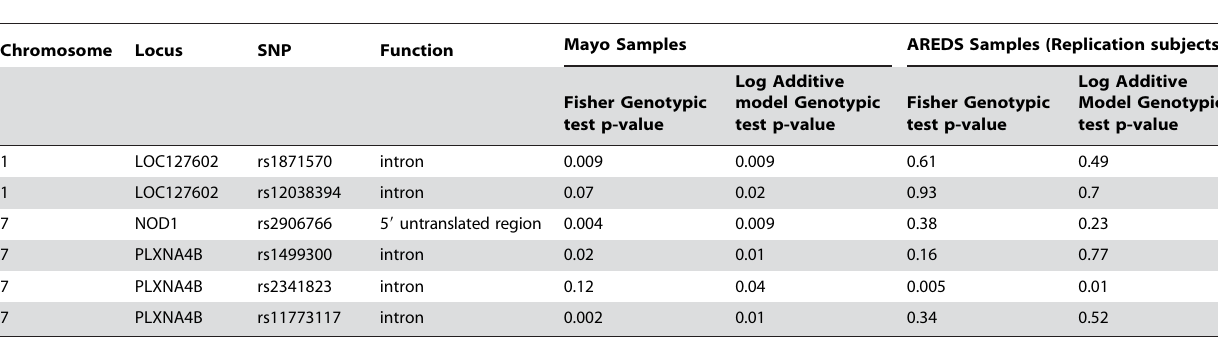
Table 4. Results of genotyping 6 SNPs from the 3 loci in Table 3 with possible association with AMD in the Mayo subjects on 1,598 (1,280 cases and 318 controls) AREDS